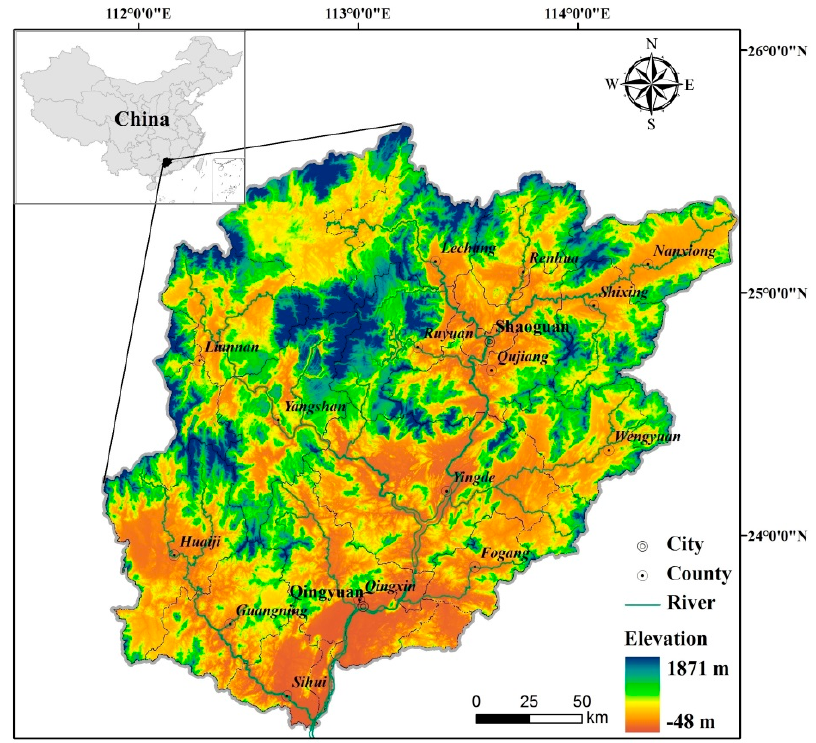
Figure 3. Location and topographical condition map of the study area.